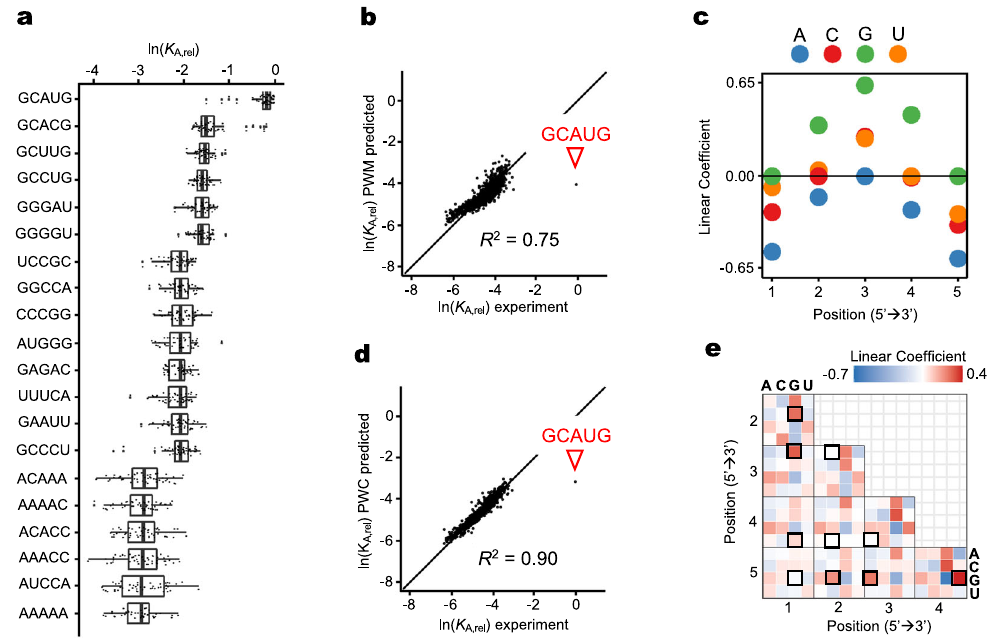
Fig. 2 | Analysis of RbFox af fi nity distribution with quantitative binding mod- els.a Relativeaf fi nities( K A,rel )forselected5-merRNAvariants,indicatedontheleft. 48 K A,rel valuescorrespondtoall5-merwith7randomizednucleotides(verticalline: median; box: variability through lower quartile and upper quartile; whiskers: variability outside the lower and upper quartiles). b Correlation between experi- mental K A,rel values for each 5-mer (median value, panel a ) and values calculated with the Position Weight Matrix (PWM) binding model (triangle: consensus 5-mer; line: diagonal, y = x ; R 2 : correlation coef fi cient). c Linear coef fi cients for each